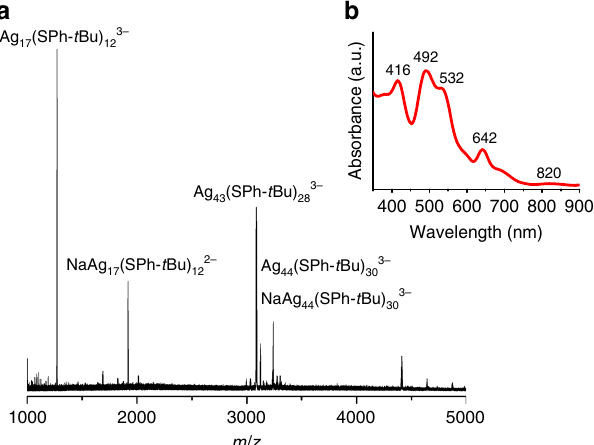
Fig. 1 Schematic illustration of the evolution process. Thiolate-stabilized Ag nanoclusters were obtained through sodium-borohydride-reduction of AgSPh- t Bu precursor. Discrete Ag-thiolate clusters were captured by ESI- MS as the key intermediates in the evolution process